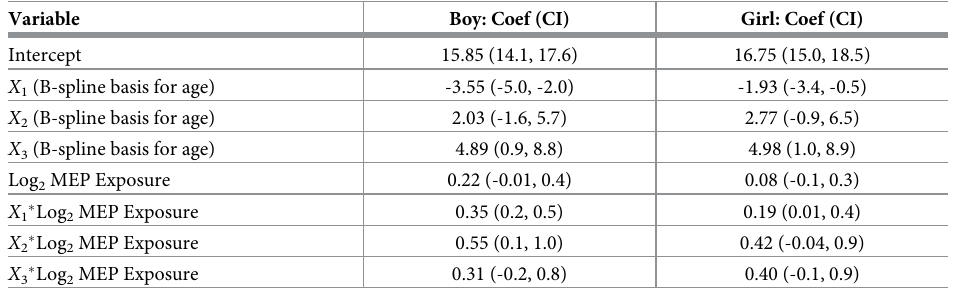
Table 2. Estimated fixed effect coefficients comparing class probabilities to the probability of Class 4 for a dou- bling of MEP and associated 95% confidence interval from the linear mixed effect model fit to the CHAMACOS data, boys and girls separately.